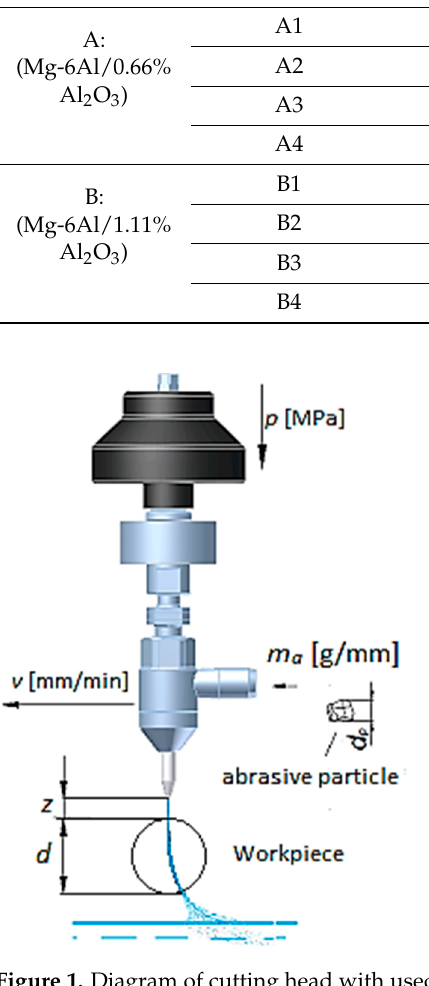
Table 3. Technological parameter levels used in each experiment.